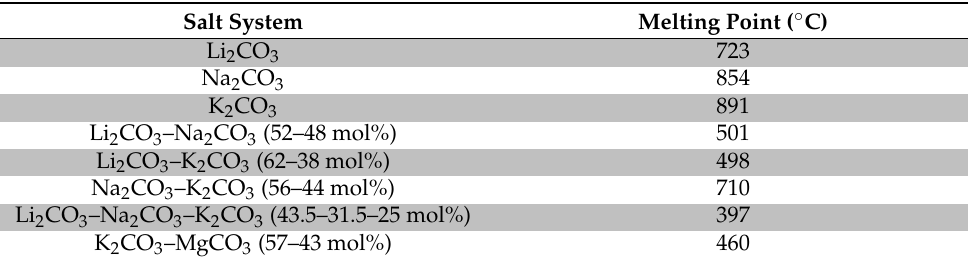
Table 1. Melting points of single alkali carbonate salts and common carbonate eutectic mixtures